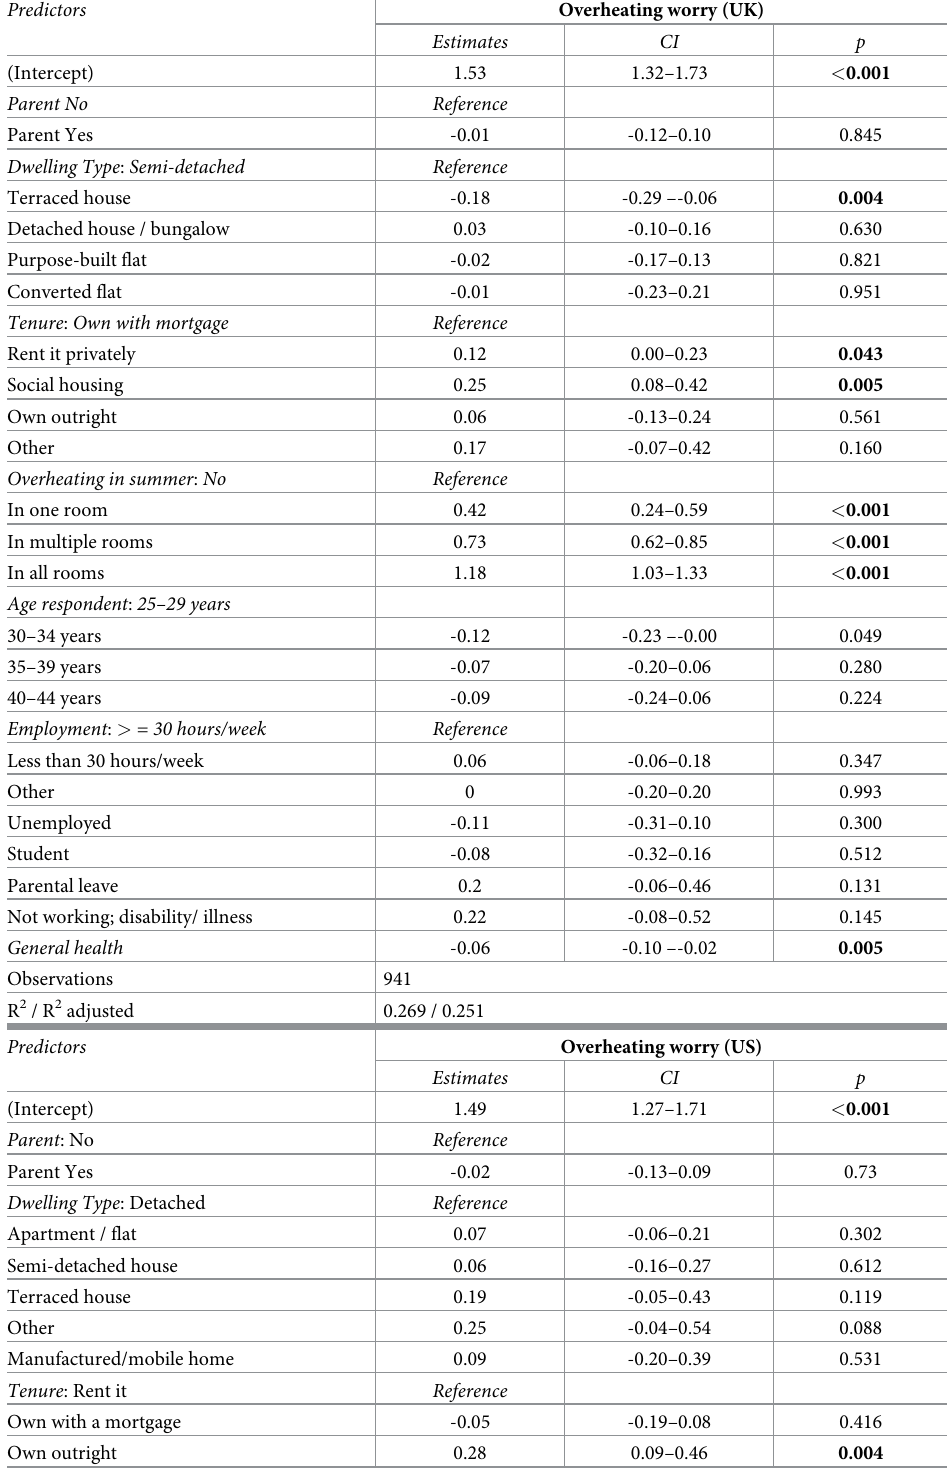
Table 5. Relating overheating worry to other variables. a) Regression results UK sample. b) Regression results US